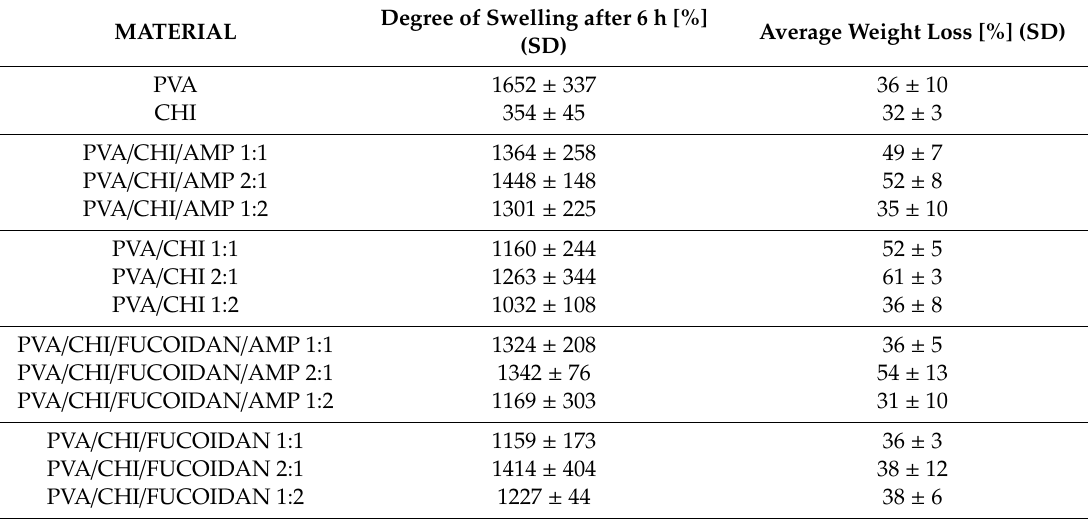
Table 3. Degree of swelling and solubility degree for the prepared